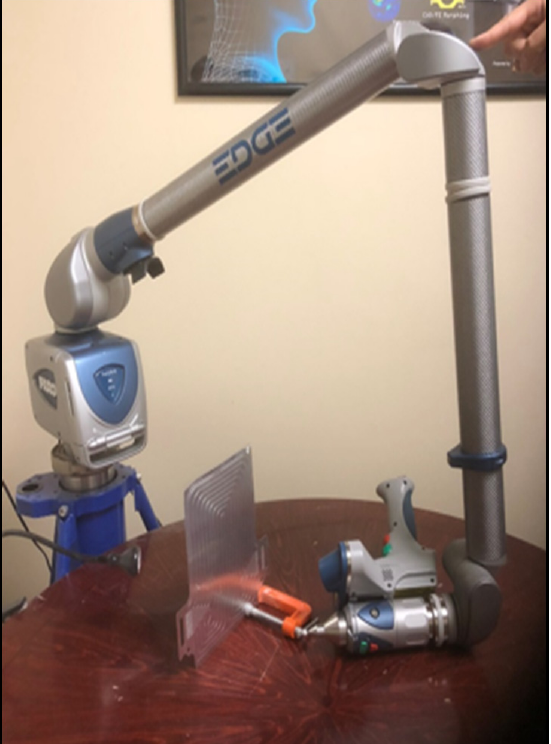
Figure 1. 3D Laser scanning of microchannel cold plate used for cooling the lithium-ion battery.